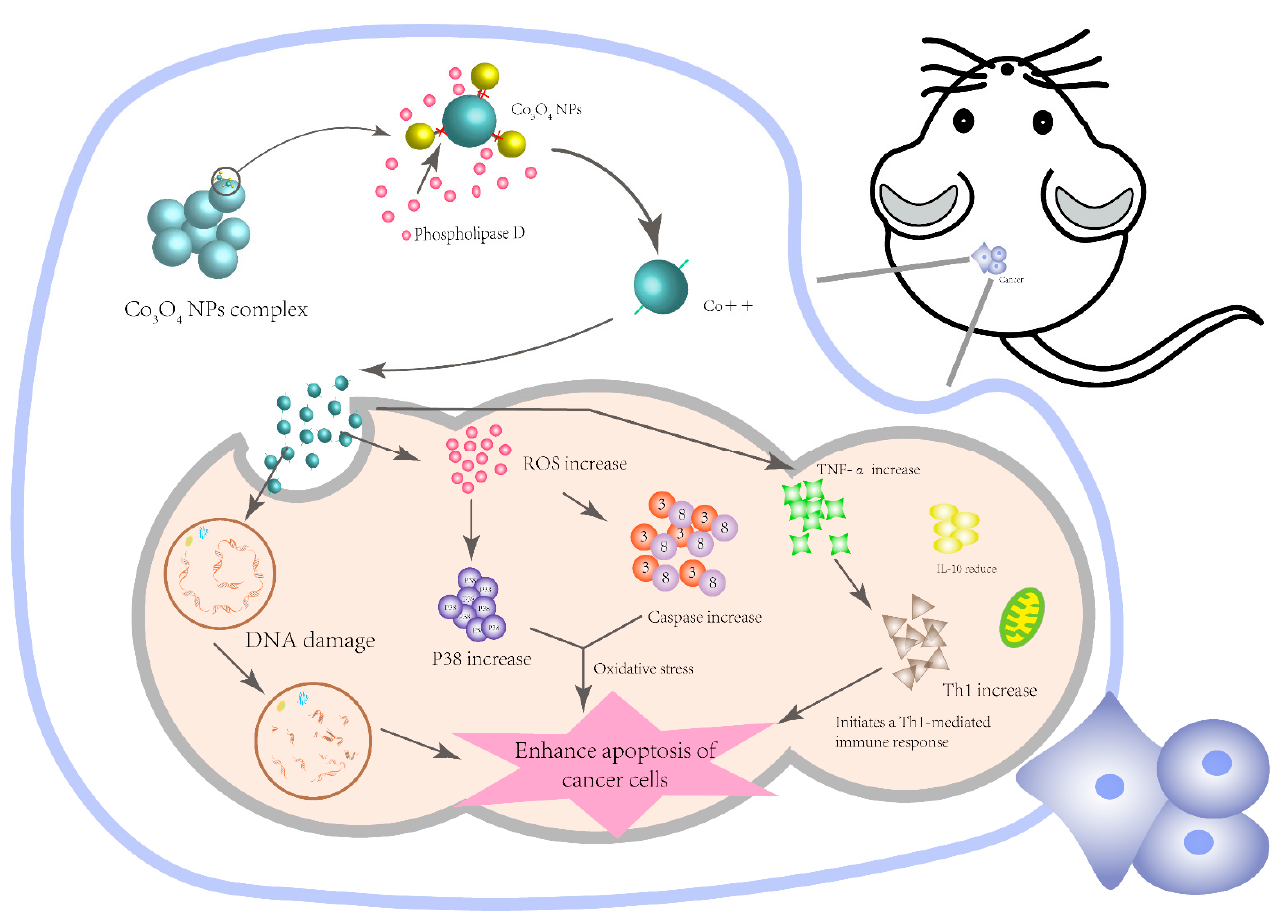
Figure 6. Potential mechanisms of cobalt oxide and its complex on cancer cell apoptosis. Cobalt oxide nanoparticles can be directly used as anticancer drugs to induce cancer cell damage and can also be used as chemical sensitizers and protective agents during